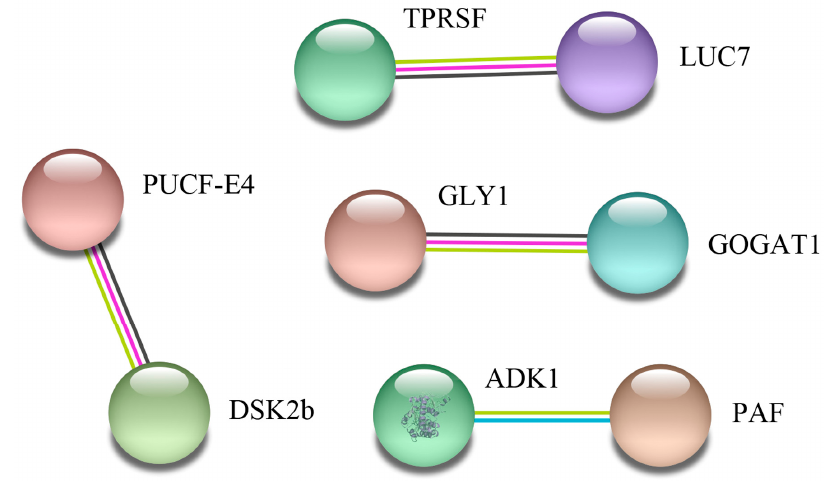
Figure 5. A protein interaction network of differentially regulated proteins between 8723 and P138 seedlings under salt stress. The network was built using a String program (http://www.string-db.org/), with confidence greater than 0.5. The nodes represent the protein, and the line color indicates the type of interaction evidence.